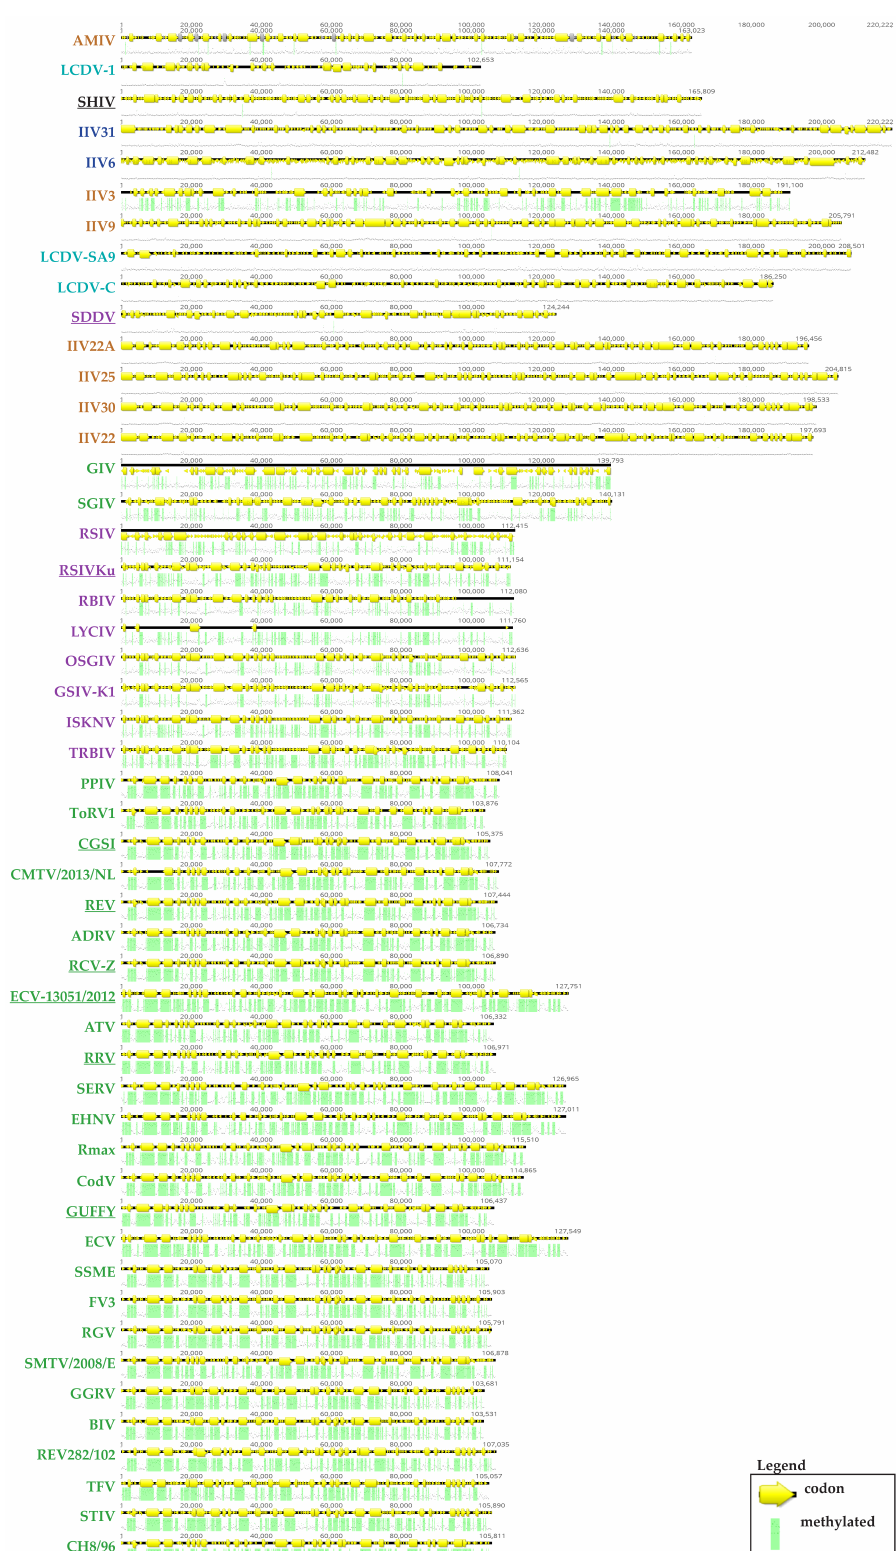
Figure 5. In silico prediction of methylation sites of 50 iridovirid genomes. The Geneious CpG Plugin (Biomatters Ltd., Auckland, New Zealand) predicts likely methylation sites according to the Hidden Markov models described by Richard Durbin. Green indicates potential methylation sites and yellow arrows indicates viral coding region of a genes. Methylation patterns IIVs versus VIVs could be distinguished, with the exceptions of IIV3 from IIVs and SDDV from SDDV as well as